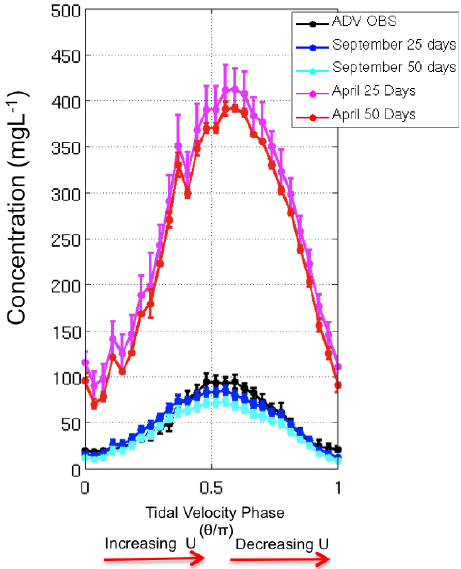
Figure 11. Phase averaged concentration observed using the ADV, and estimated by model runs that defined ( τ ) and ( τ ) using the power law fits to the September and April ceq crinit profiles with swelling times of 50 and 25 days (see